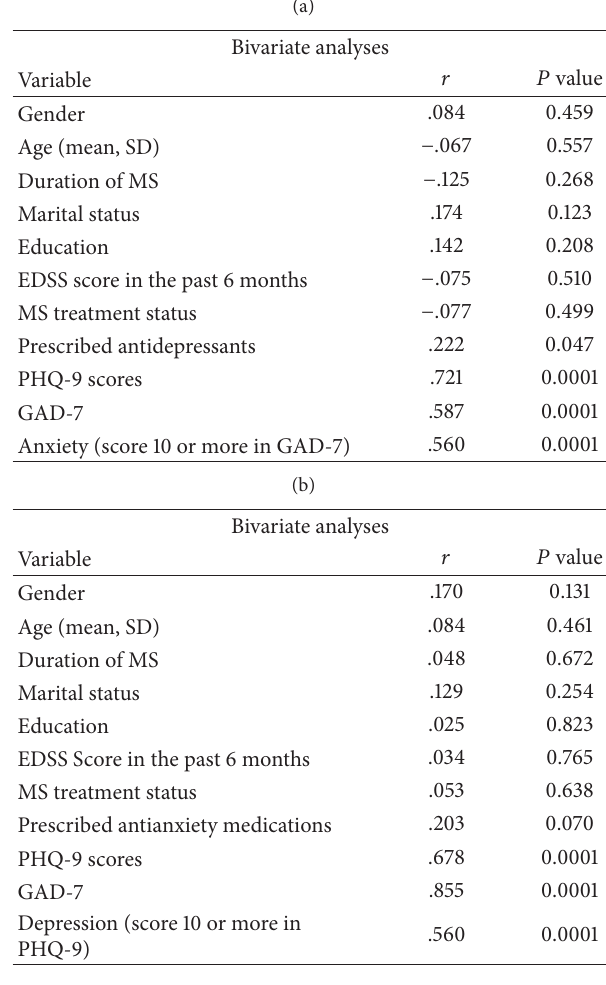
Table 3: (a) A summary of bivariate analyses of individuals with MS who are suffering depression. (b) A summary of bivariate analyses of individuals with MS who are suffering anxiety.